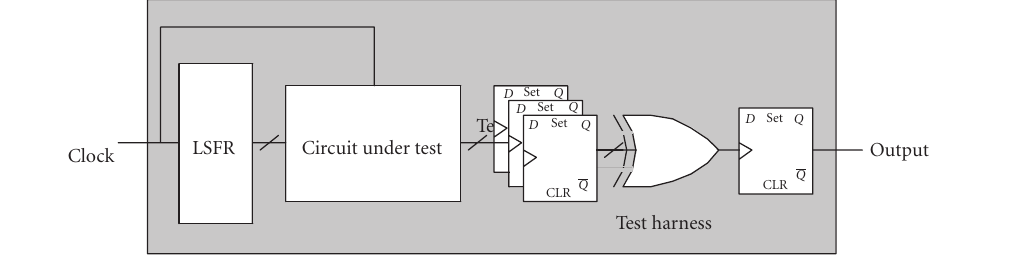
Figure 3: Test harness.